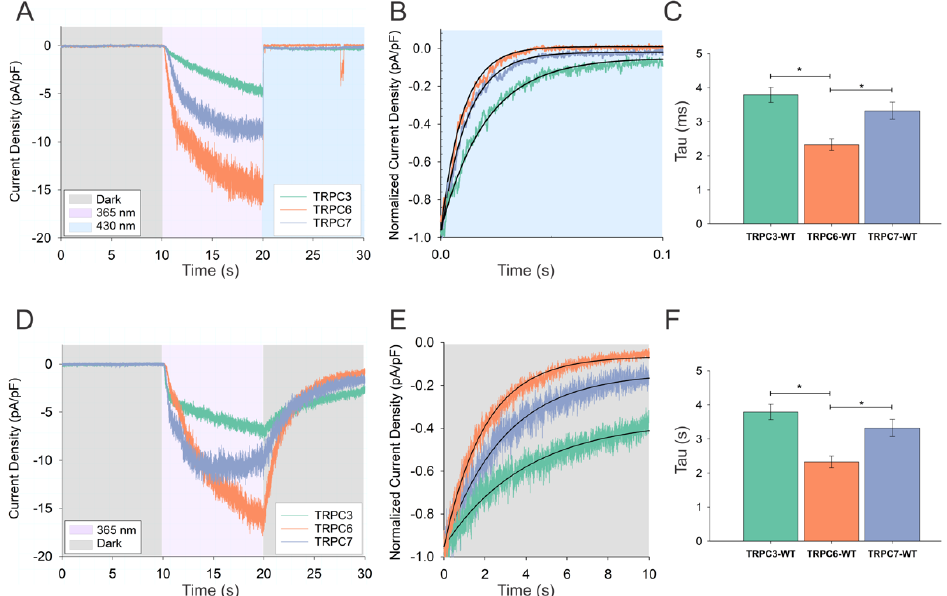
Figure 3. OptoDArG − activated TRPC isoforms (TRPC3–TRPC6–TRPC7) display variable decay kinetics in blue light and in the dark. ( A ) Representative recording showing the gating kinetics induced by instantaneous photoisomerization of OptoDArG (20 μM) to cis using UV light (365 nm, 10 s; violet) and then to trans conformation using blue light (430 nm, 10 s; blue) in a whole − cell gap − free recording (holding potential: − 40 mV, baseline adjusted to 0 mV, normalized by capacitance). ( B ) Exponential fit of the representative normalized time courses of TRPC3 (green), TRPC6 (orange), and TRPC7 (blue) current deactivation during blue light illumination. ( D ) Representative current traces showing gating kinetics induced by thermal relaxation of OptoDArG (30 μM) in TRPC3 (green), TRPC6 (orange), and TRPC7 (blue) after UV illumination was switched off (dark). ( E ) Exponential fit of representative normalized time courses of TRPC3 (green), TRPC6, (orange) and TRPC7 (blue) current deactivation after UV illumination was switched off. ( C , F ) Bar charts illustrating the deactivation time constant (Tau) for blue light ( C ) and after UV was switched off (dark) ( F ) for TRPC isoforms. Number of biological repetitions for each condition ≥ 6. The data are the means ± SEM; two-tailed t − test or Mann–Whitney test was applied; * p < 0.05.